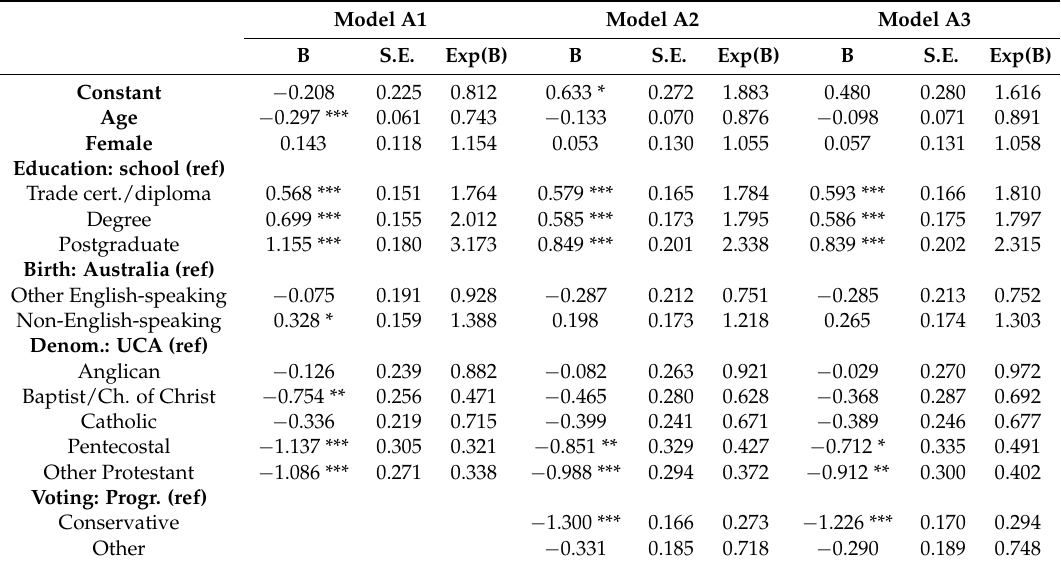
Table 5. Prediction of belief in anthropogenic climate change beliefs from demographics, denomination, and political